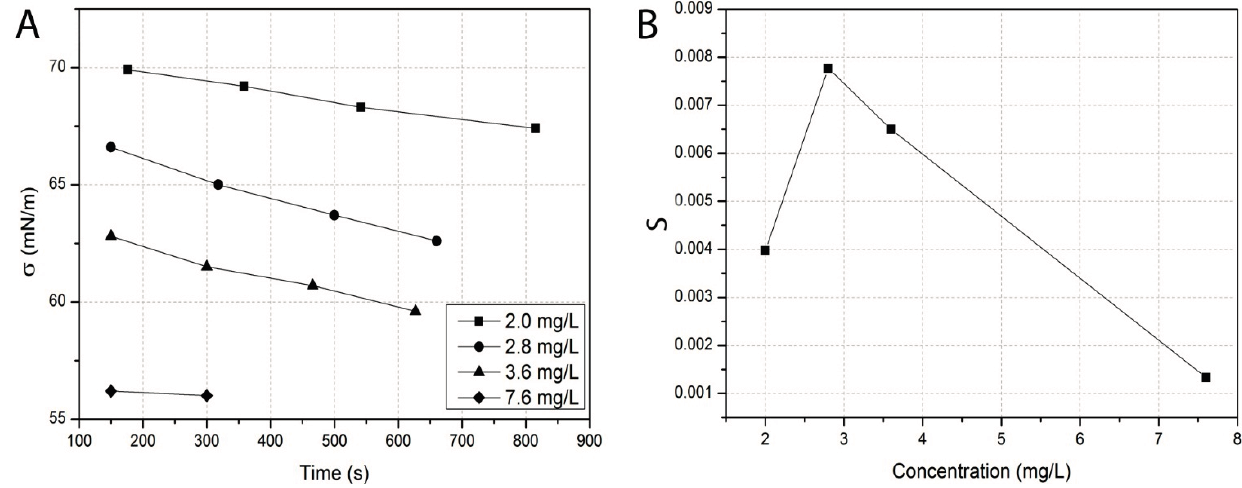
Figure 5. Influence of polymer concentration on the surface tension in the intermediate regime on the solution of methylcellulose A15C at 20 °C. ( A ) Kinetics of variation of the surface tension; ( B ) Slope S as a function of polymer